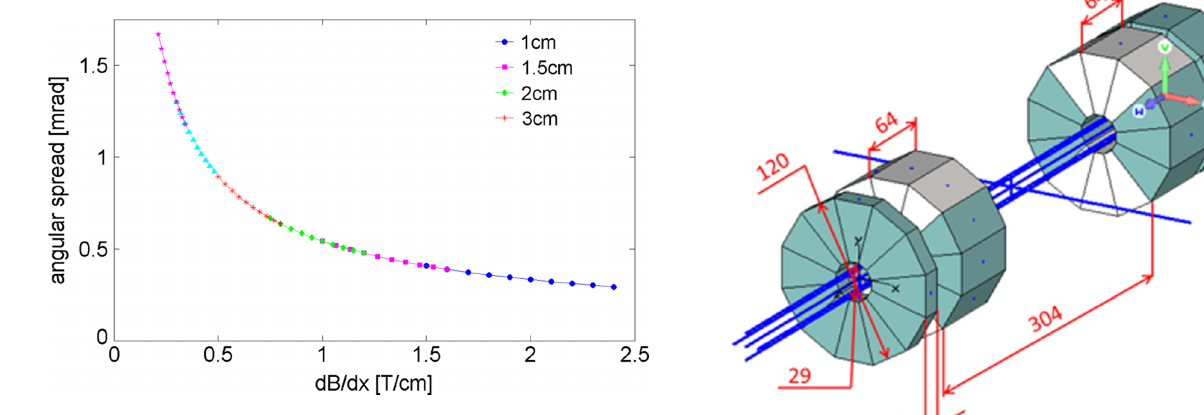
FIG. 13. Dependence of the rms value of the angular spread on the magnetic field gradient (linearly increasing magnetic fields with different maximum field strengths and ramp lengths shown in Fig. 12 were used in the calculations).